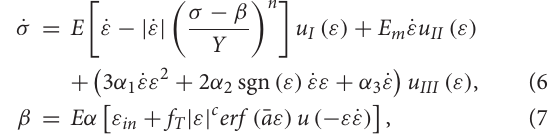
FIGURE 2 | Twinning hysteresis ( f T variation in Y (D) variation in α (E) variation in n